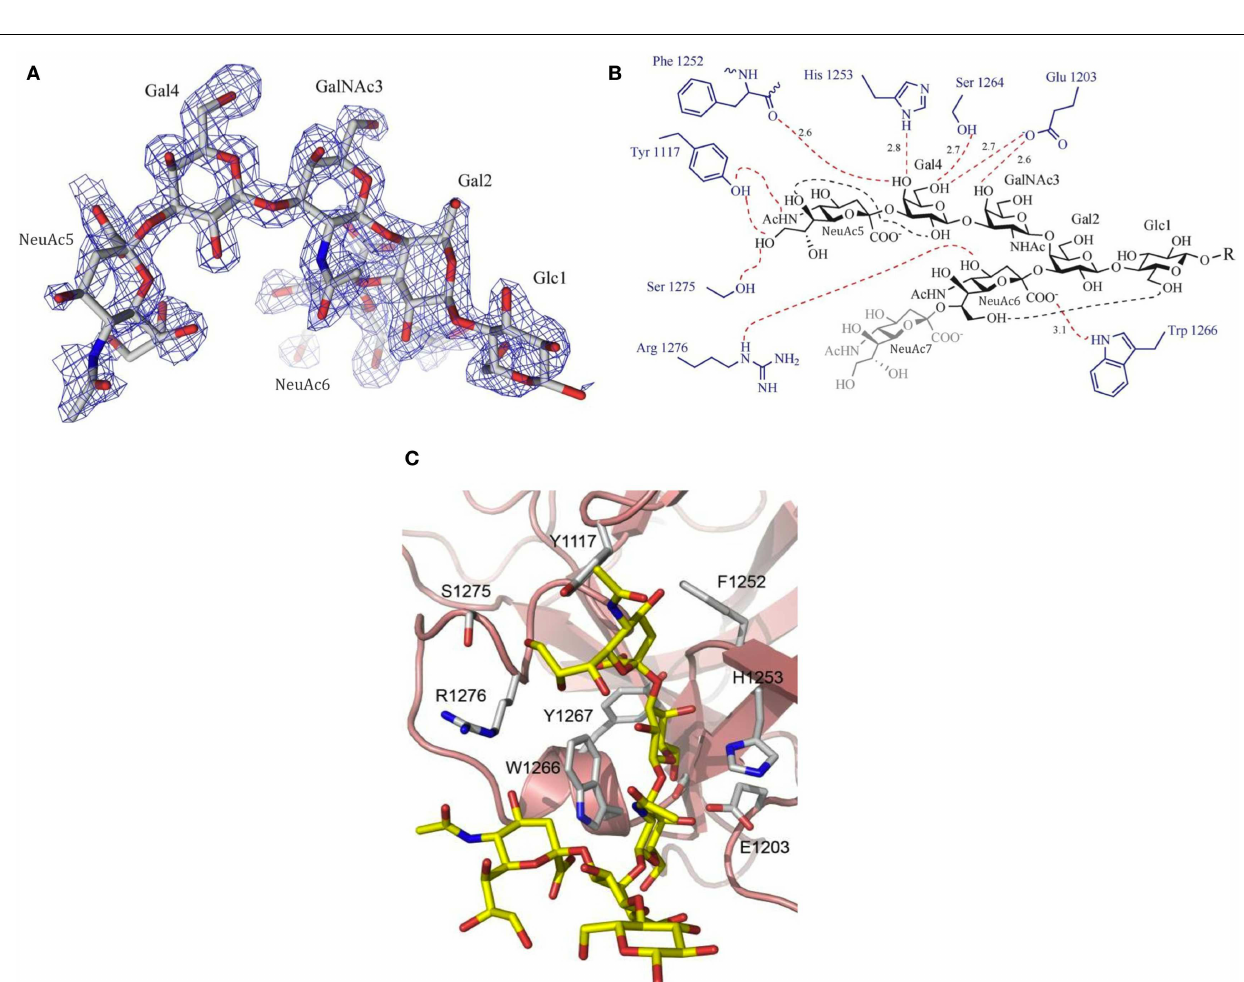
FIGURE 3 | Example of ganglioside recognition [here: GT1b (analog) and its interaction with botulinum neurotoxin typeA (BoNT/A)] . (A) Experimental electron density (Fo–Fc omit map) of the ganglioside head group. (B) Schematic drawing of the interactions between GT1b and BoNT/A.